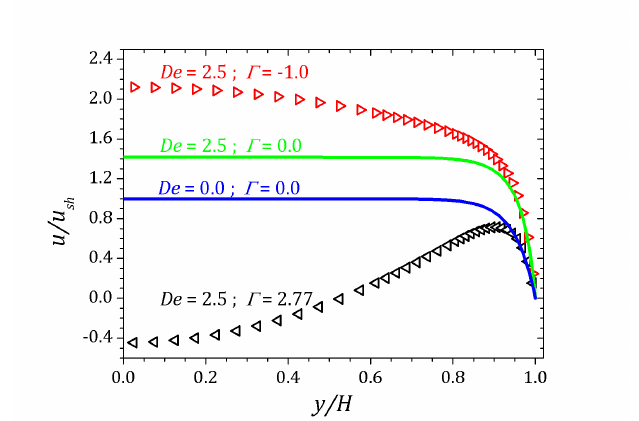
Figure 12. Velocity profiles for a sPTT fluid flow subject to an external pressure gradient. Results for ε = 0.1, κ =